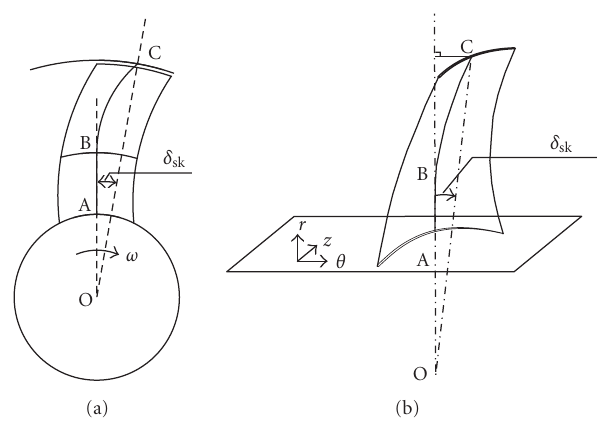
Figure 1: Schematic of stacking line of blade. Table 1: Key design parameters of archetypal